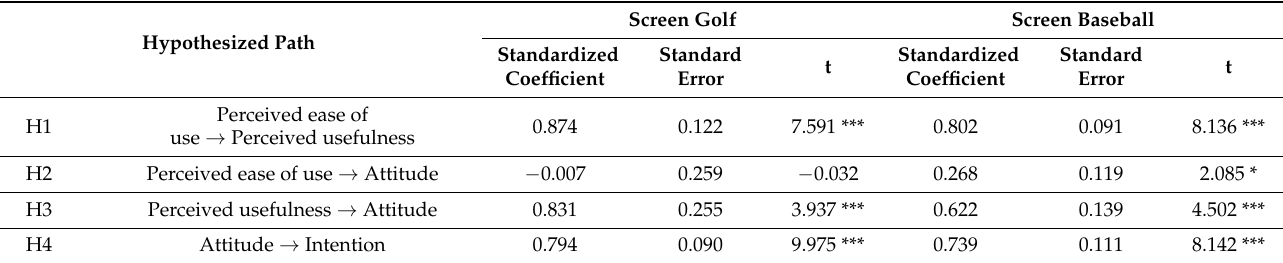
Table 6. Summary of the tested hypotheses (screen golf vs. screen baseball).